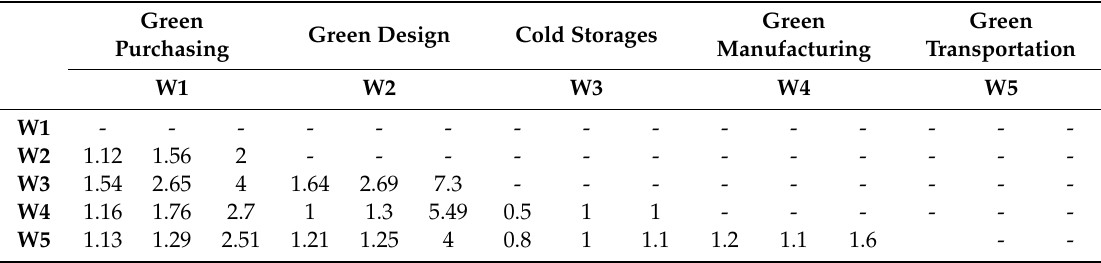
Table 11. Paired comparison matrix of KPIs in the FMCG industry green supply chain, based on integration of experts in executive